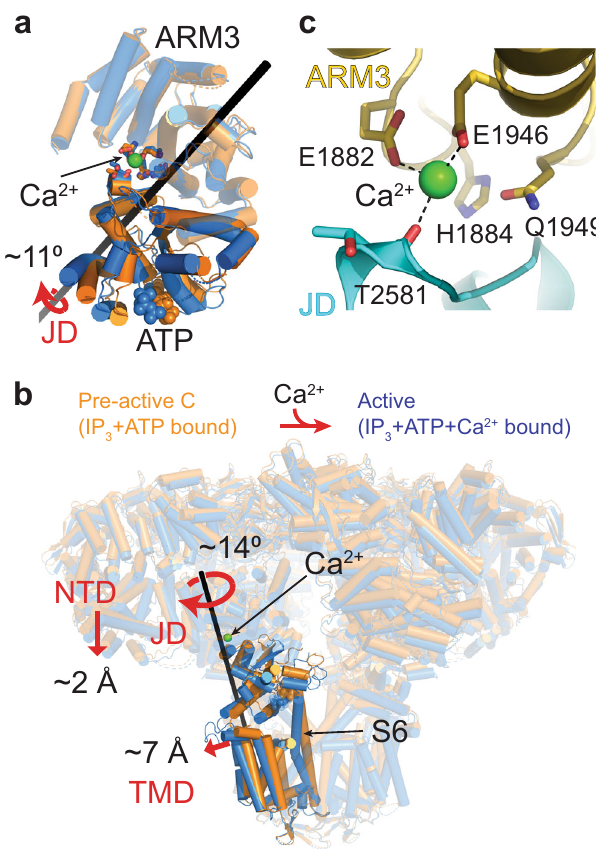
Fig. 3 Conformational changes coupling Ca 2 + binding to pore opening. a Comparison of the JD (shown in full colors) orientation relative to the ARM3 (shown transparent) in the pre-active-C (orange) and active (blue) structures. The black bar indicates the axis for the rotation of the JD. Ca 2 + and ATP are shown as spheres. b Global conformational changes induced by Ca 2 + binding are depicted similar to Fig. 2. c Close-up view of the Ca 2 + binding site in the active conformation. Domains are colored as in Fig.